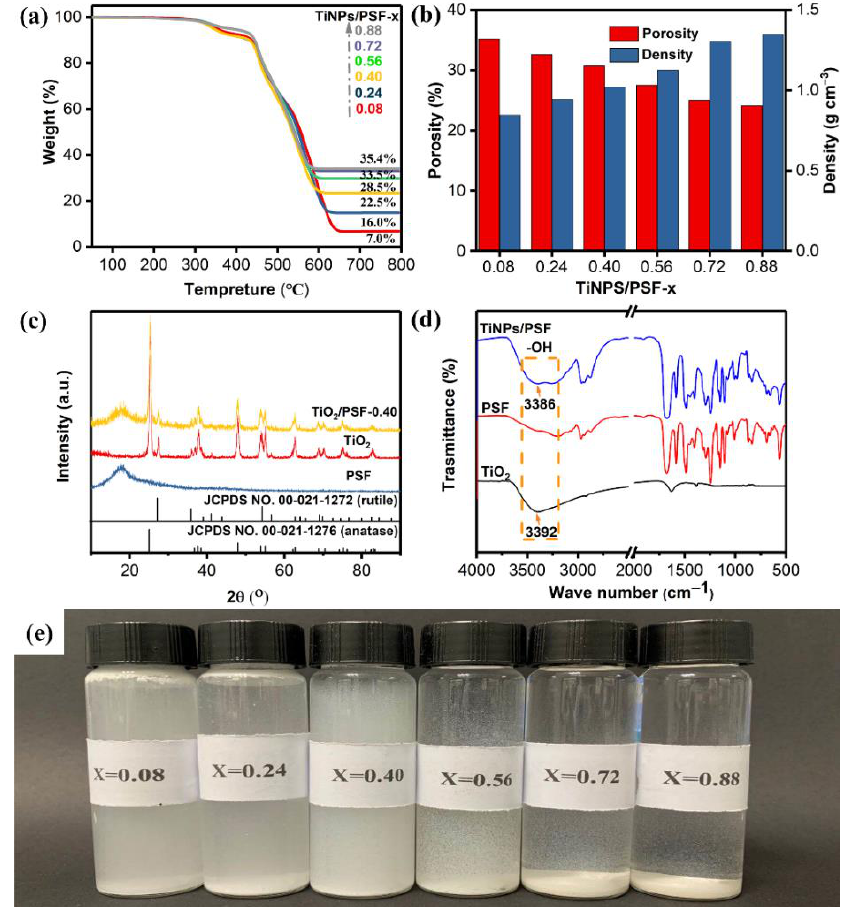
Figure 2. ( a ) Thermal gravimetric analysis (TGA) curves of TiNPs/PSF-x composite microspheres (x from 0.08–0.88) and the increasing trend of TiO 2 content in composite microspheres. ( b ) porosity and density of TiNPs/PSF-x composite microspheres (x from 0–0.88). ( c ) X-ray diffractometer (XRD) patterns of the TiO 2 nanoparticle, PSF microsphere and TiNPs/PSF-0.40 composite microsphere. ( d ) FTIR spectra of the TiO 2 nanoparticle, PSF microsphere and TiNPs/PSF-0.40 composite microsphere. ( e ) settlement resistance test (2 h) of TiNPs/PSF-x composite microspheres. Figure 2c displays the XRD pattern of PSF, P25 TiO 2 and TiNPs/ Table 1. The microsphere size, actual effective content, density and porosity parameters of PSF-0.40 composite microspheres. PSF shows a board diffraction peak at 2 θ of 17.89 ◦ . P25 TiNPs/PSF. TiO 2 exhibits several characteristic peaks belonging to anatase TiO 2 (JCPDS cards No. 00- 021-1272) at 2 θ of 25.24 ◦ (101), 37.84 ◦ (004), 48.13 ◦ (200), 53.88 ◦ (105), 55.02 (211), and 62.82 ◦ (204), 68.76 ◦ (116), 70.30 ◦ (220), 75.03 ◦ (215), 82.66 ◦ (224), and a characteristic peaks of rutile TiO 2 (JCPDS cards No. 00-021-1276) at 2 θ of 27.44 ◦ (110) [32,33]. The above-mentioned diffraction peaks can all be found in the XRD pattern of the TiNPs/PSF-0.40 composite, showing the successful immobilization of P25 on